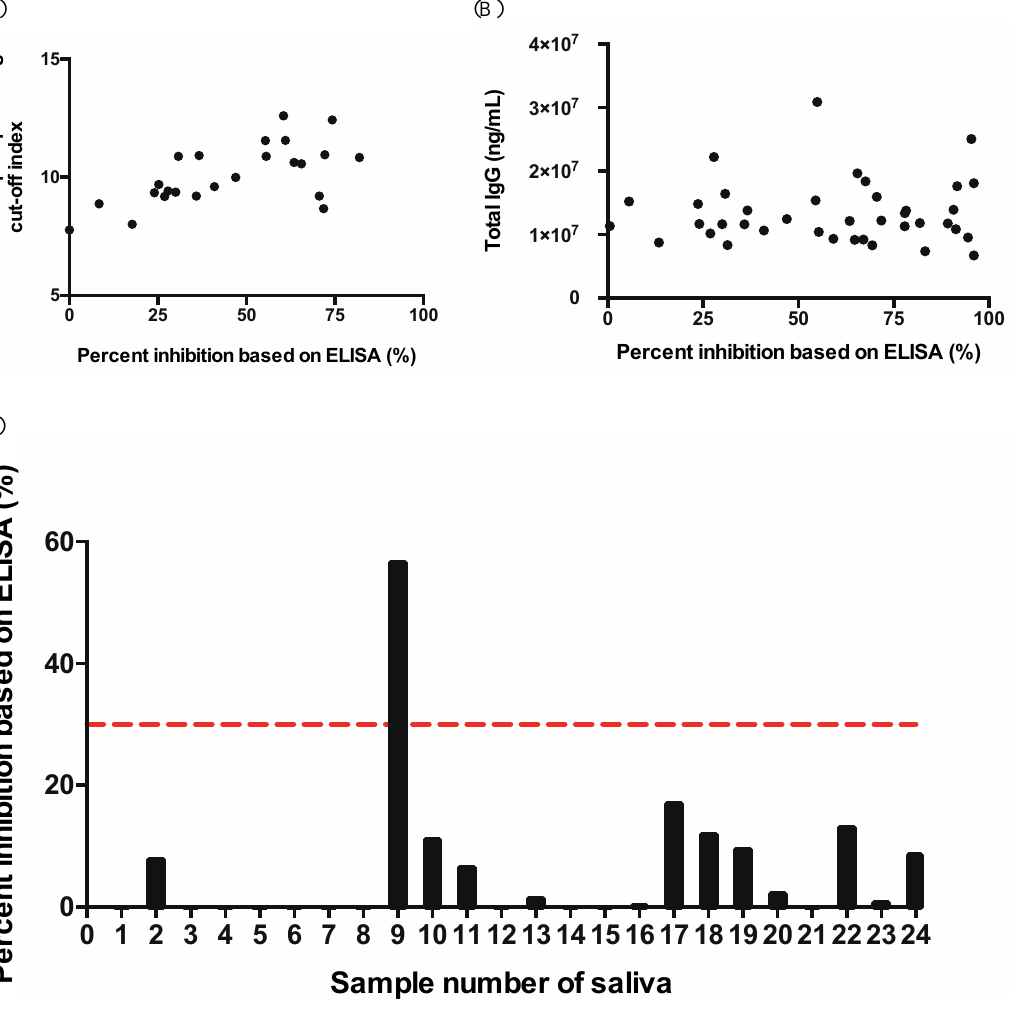
Figure 5. ( A ) Correlation between the SARS-CoV-2 spike protein IgG antibody and neutralizing antibody from ELISA (Rho = 0.5724, p -value = 0.0035). The x -axis is the percent inhibition of the neutralizing antibody. The y -axis is the cut-off index for the SARS-CoV-2 spike protein IgG anti- body. ( B ) Correlation between the human total IgG antibody and neutralizing antibody from ELISA. The x -axis is the unit of percent inhibition of the neutralizing antibody. The y -axis is the amount of total IgG antibody (ng/mL). ( C ) Neutralizing antibody tested from a saliva sample. We labeled the negative percent inhibition as zero. The x -axis is the saliva sample number. The y -axis is the unit of percent inhibition of the neutralizing antibody. The red dotted line represents the 30% inhibition based on ELISA, which is the cut-off value (positive or negative) of this assay.